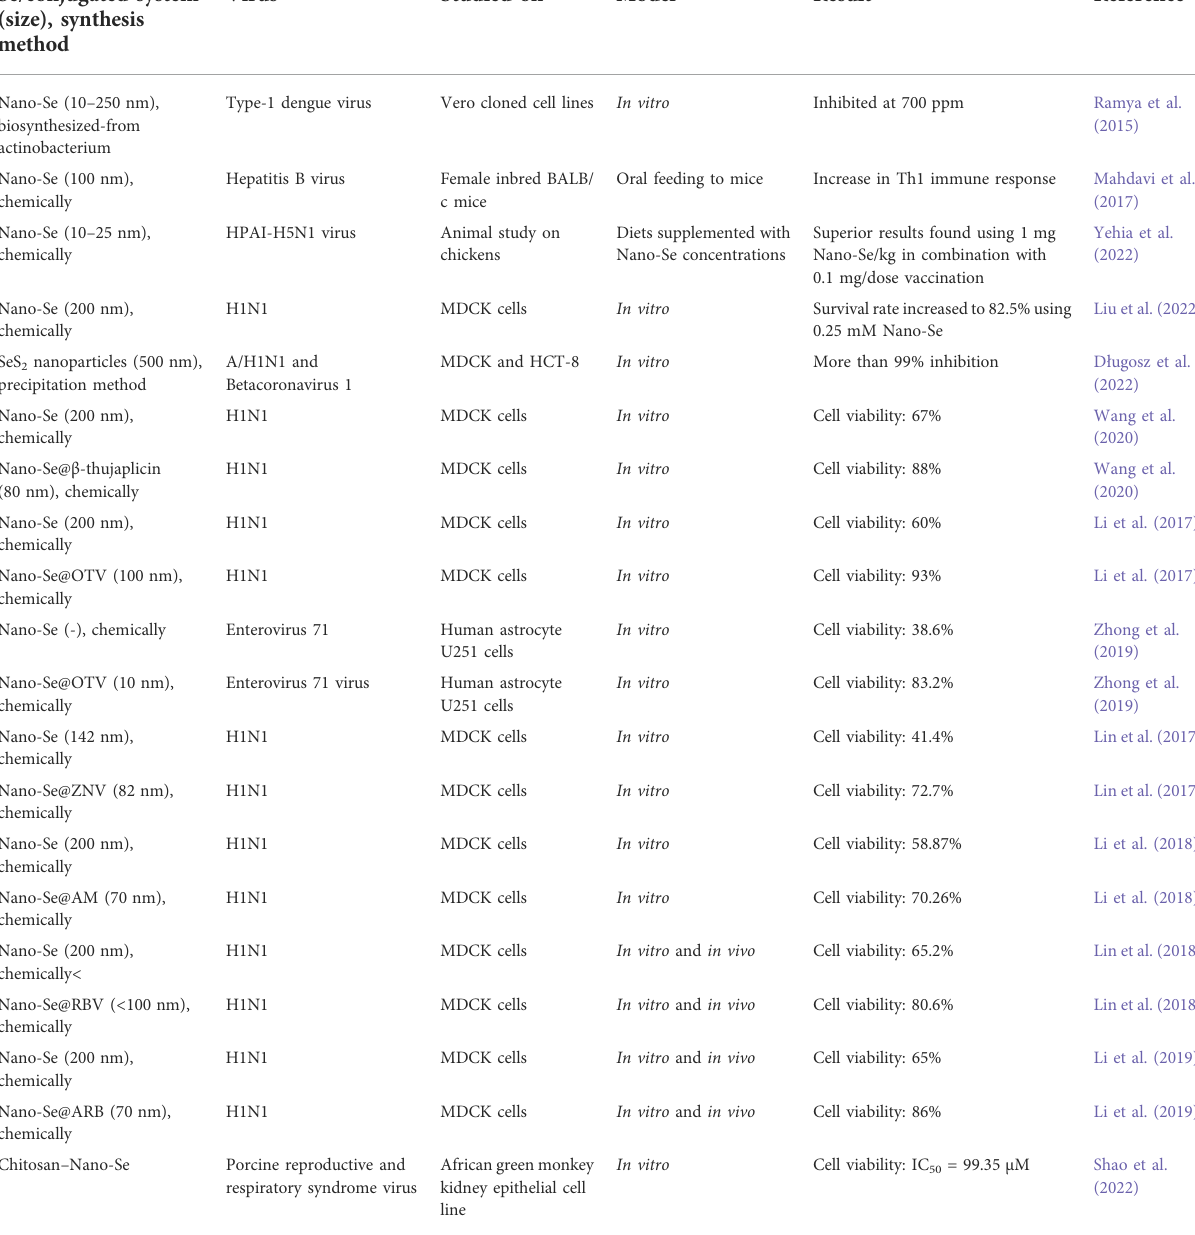
TABLE 2 Nanoselenium particles and their conjugated systems with studied antiviral activity against different viruses. Se/conjugated system (size),